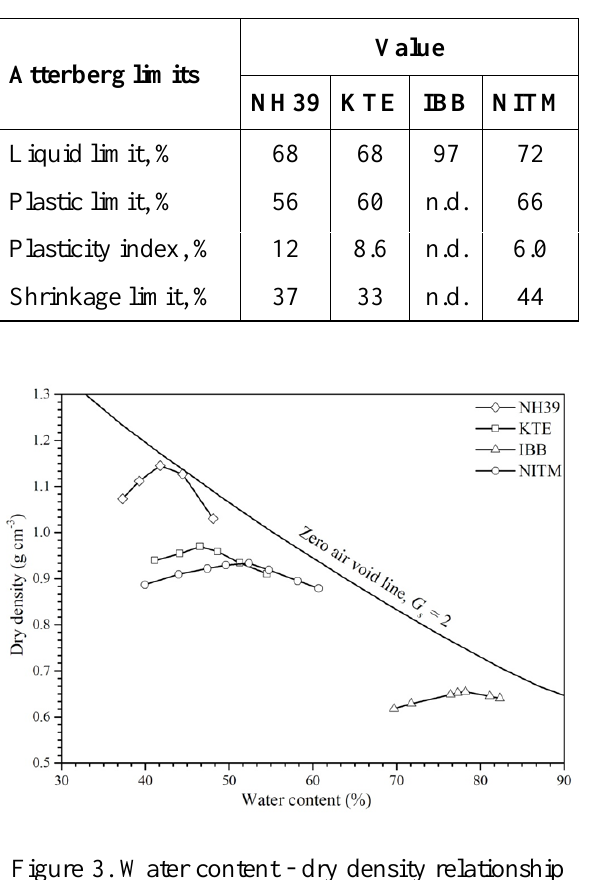
Table 3. Atterberg limits of Northeast-Indian peats; data from Paul et al . (2018). n.d. = not determined.